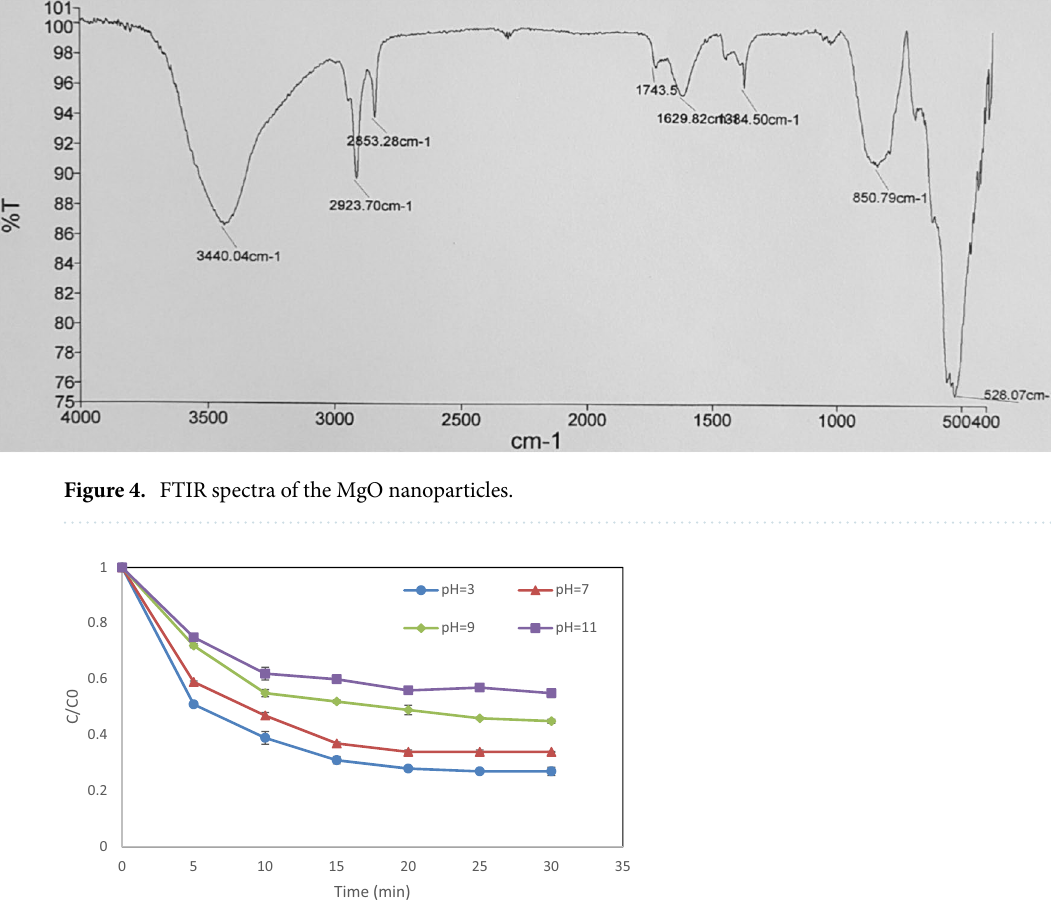
Figure 5. Impact of pH on DEX degradation: hydrogen peroxide dosage = 1 mM, DEX content = 20 mg/L, and MgO dosage = 0.05